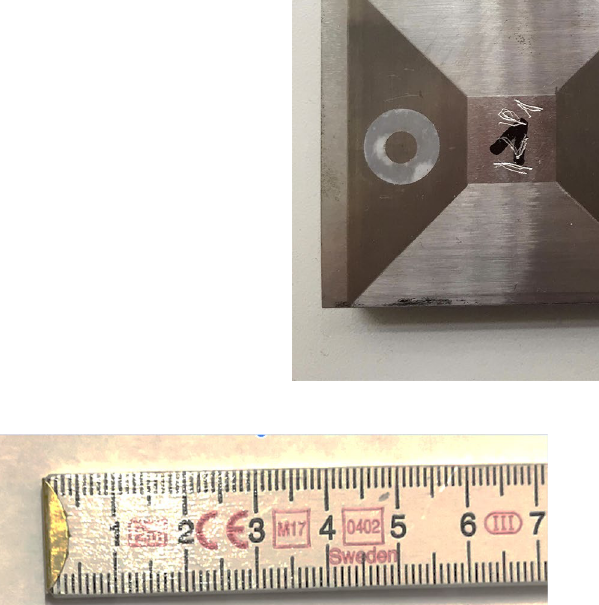
Fig. 1 Deep rolled specimen KP1 and KP 2. The measuring direction was perpendicular to the tracks